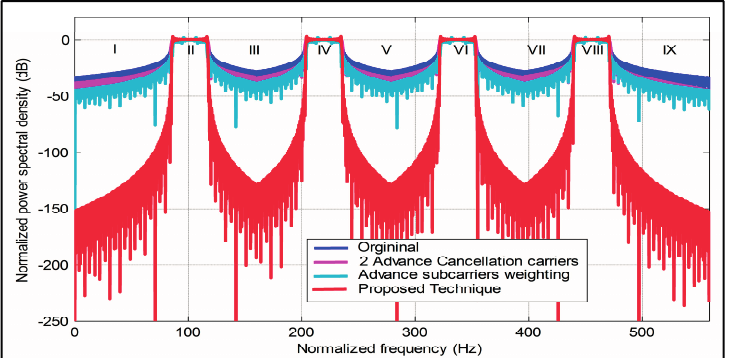
Figure 6. The PSD comparison between the proposed technique and existing techniques including ACC and ASW.